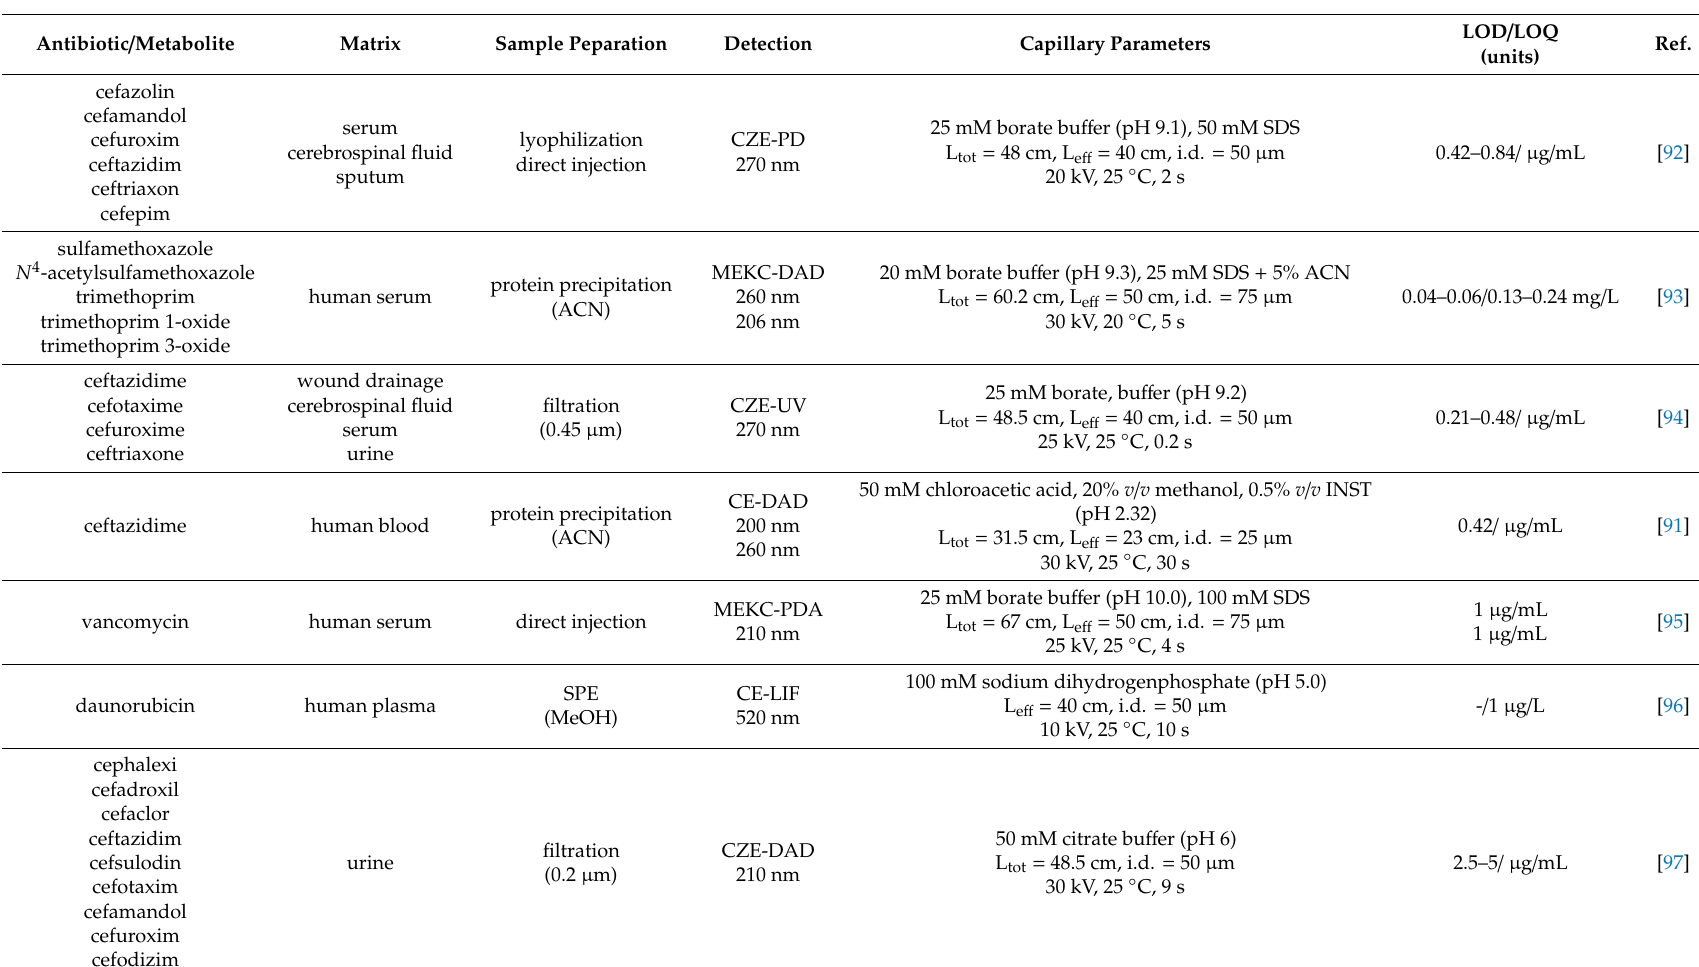
Table 3. Identification and determination of antibiotics and their metabolites by electrophoretic